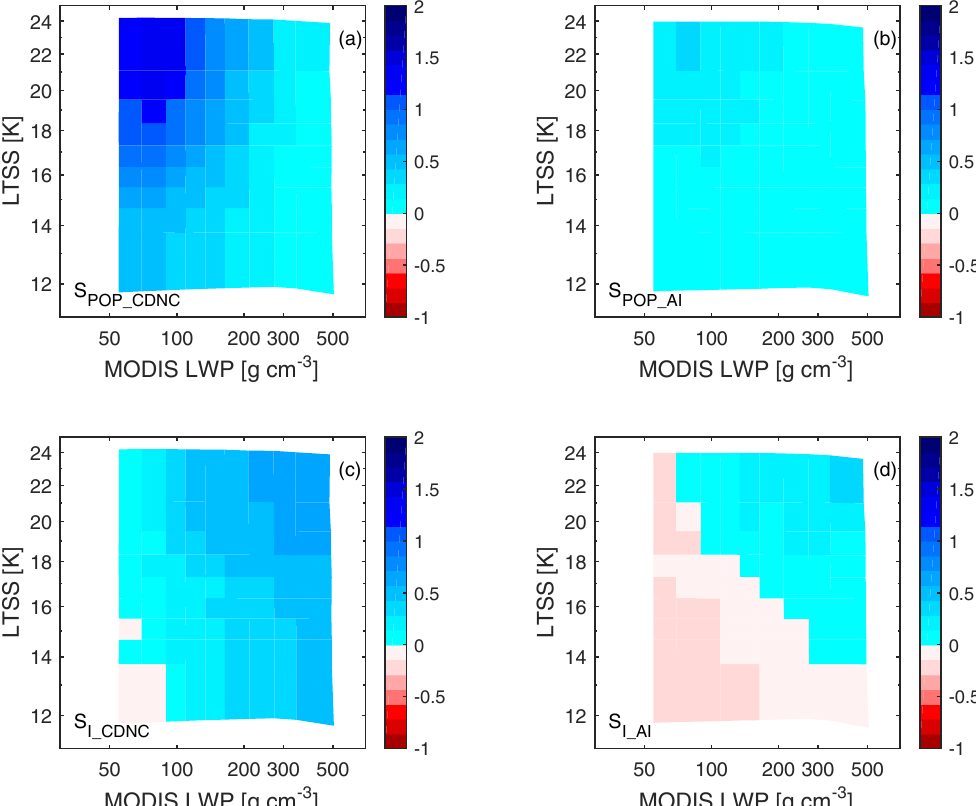
Figure 12. Distribution of (a–b) S POP_Y and (c–d) S I_Y as a function of MODIS LWP and LTSS. Rain data are from 2B-GEOPROF with a threshold of − 15dBZ. Each LTSS bin contains on average the same amount of